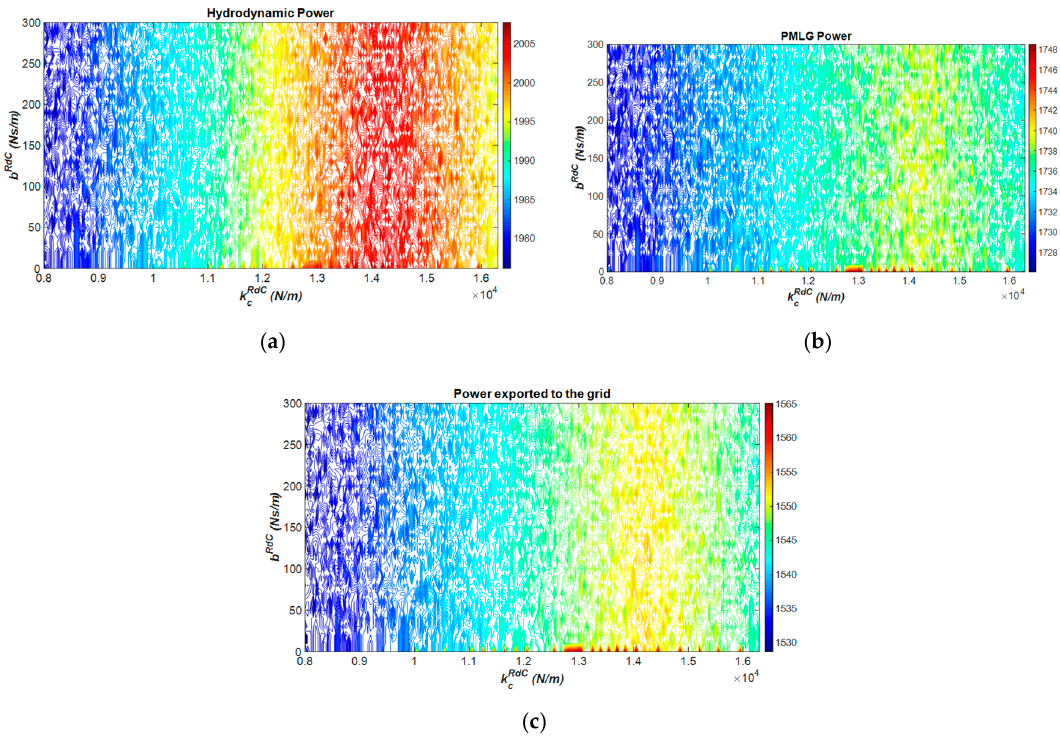
Figure 9. Grid search optimization of b RdC and k RdC c to maximize ( a ) hydrodynamic power P avg Figure 9. Grid search optimization of (cid:1854) (cid:1844)(cid:1856)(cid:1829) and (cid:1863) (cid:1855)(cid:1844)(cid:1856)(cid:1829) to maximize ( a ) hydrodynamic power (cid:1842) (cid:3035)(cid:3052)(cid:3031)(cid:3045)(cid:3042)(cid:3028)(cid:3049)(cid:3034) ; ( b ) PMLG power P avg gen ; and ( c ) power exported to the grid P avg ( b ) PMLG power (cid:1842) (cid:3034)(cid:3032)(cid:3041)(cid:3028)(cid:3049)(cid:3034) ; and ( c ) power exported to the grid (cid:1842) (cid:3034)(cid:3045)(cid:3036)(cid:3031)(cid:3028)(cid:3049)(cid:3034) .